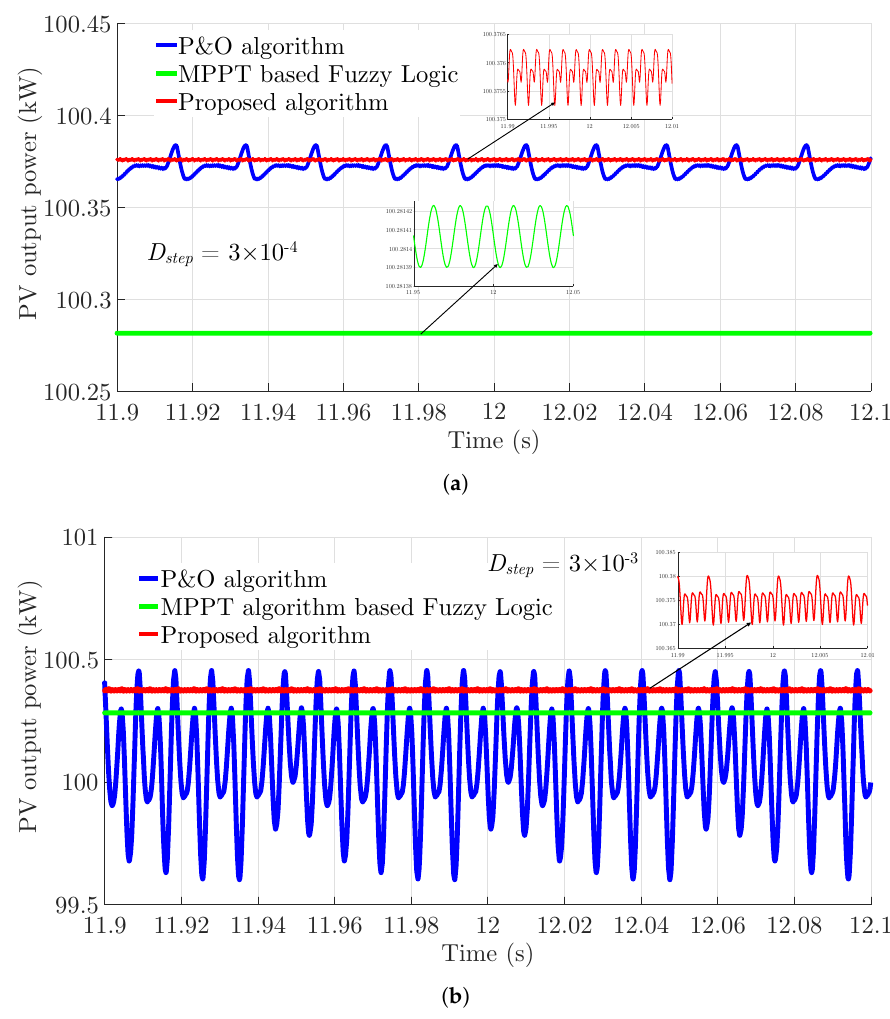
Figure 19. Comparison of the output power in the case of solar radiance being stable at 1000 W/m 2 :